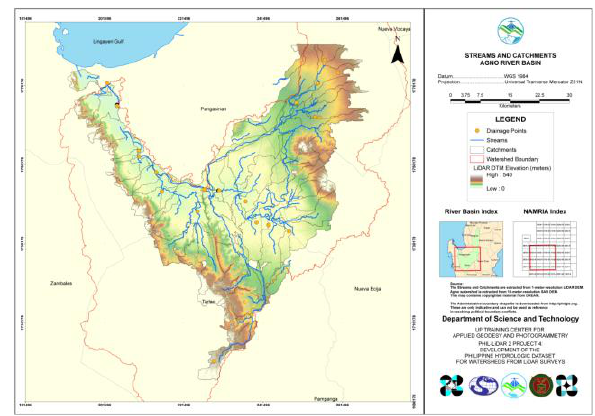
Figure 4. Sample streams and catchments map